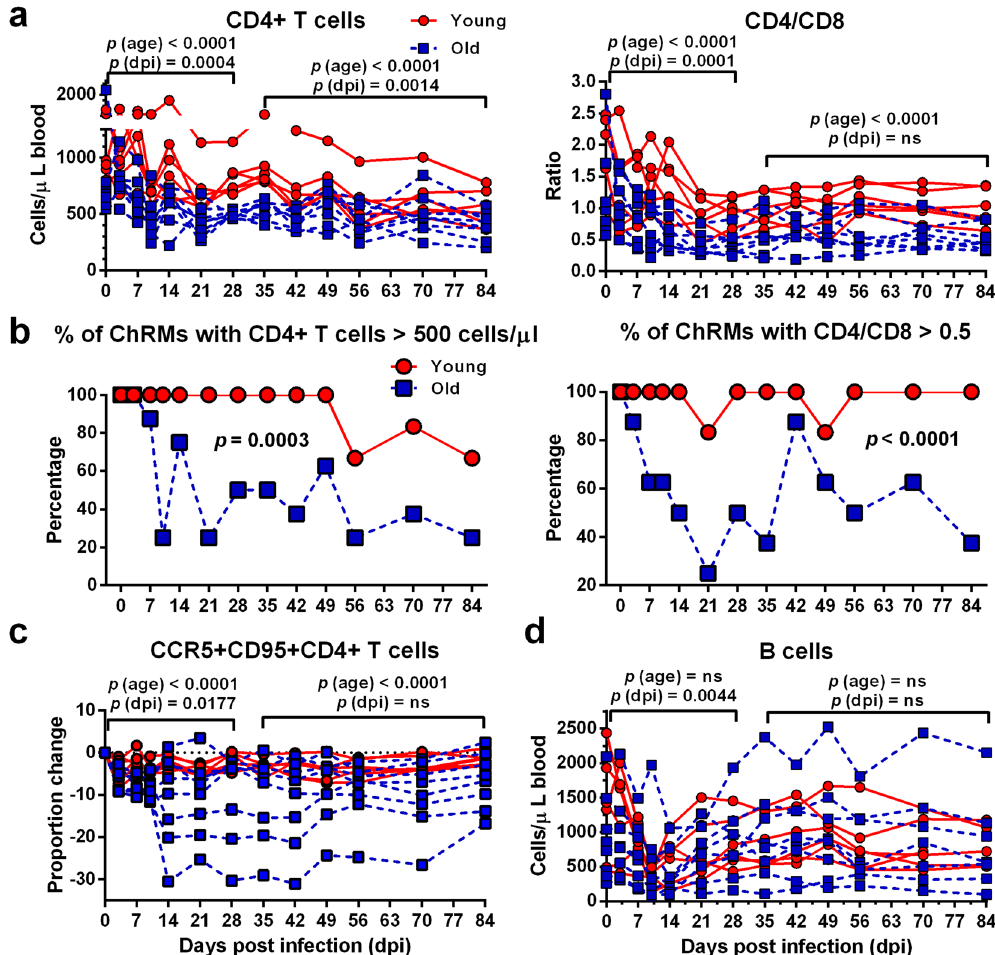
Figure 2. Old ChRM display an increased depletion of CD4 + T cells, as compared with young ChRM. ( a ) Longitudinal assessment of CD4 + T cell numbers and the CD4/CD8 ratio in the peripheral blood of the young (n = 6, red circle) and old (n = 8, blue square) groups during the 84 days after infection (dpi) is shown in dot plots. ( b ) The frequency of animals with CD4 + T cells > 500 cells/ μ l blood or a CD4/CD8 ratio > 0.5 within the young and old groups. P values were determined using the Mann-Whitney t-test. ( c ) The dynamics of CCR5 expression by CD95 + CD4 + memory T cells in the peripheral blood is shown as the differences in frequency at each dpi relative to day 0. The data are shown as the mean ± SEM. ( d ) Longitudinal assessment of B-cell levels in the peripheral blood of ChRM during early SIV infection. P (dpi) < 0.05, statistically significant differences over the acute or postacute phase, as determined by two-way ANOVA. P (age) < 0.05, statistically significant differences between the young and old groups, as determined by two-way